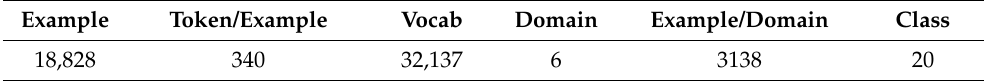
Table 2. Statistics of 20